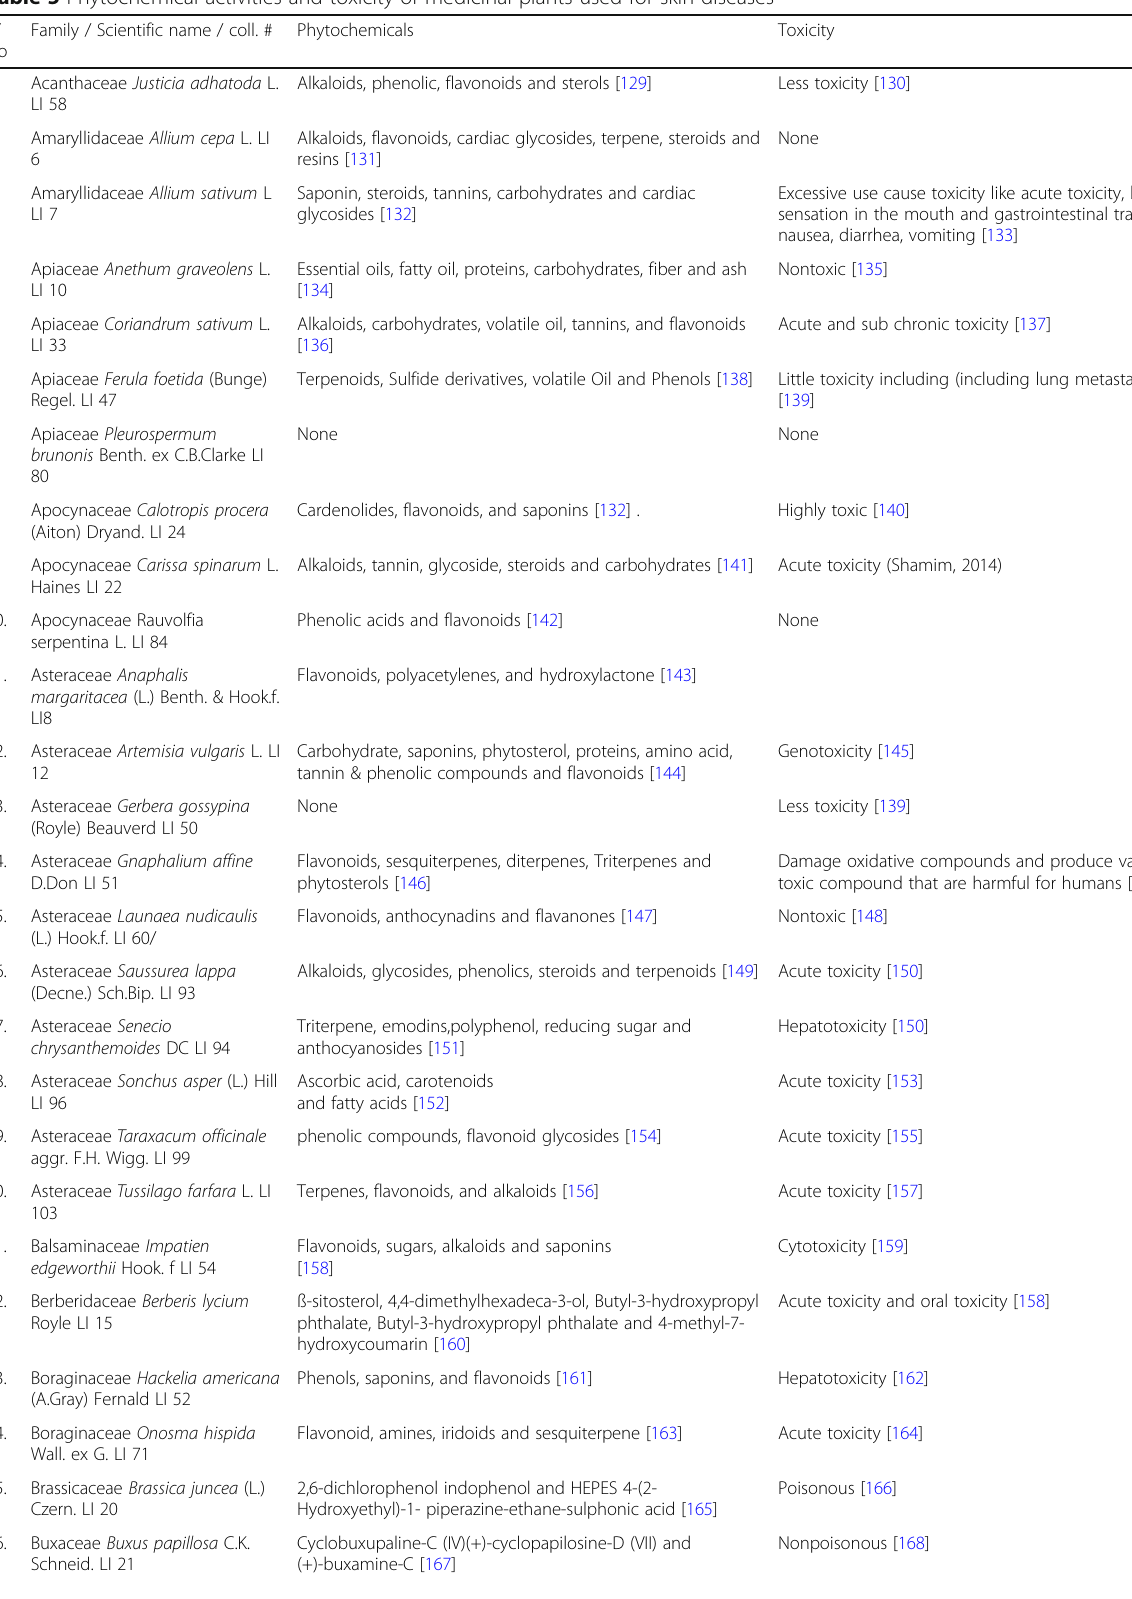
Table 5 Phytochemical activities and toxicity of medicinal plants used for skin diseases S/ Family / Scientific name / coll. # No